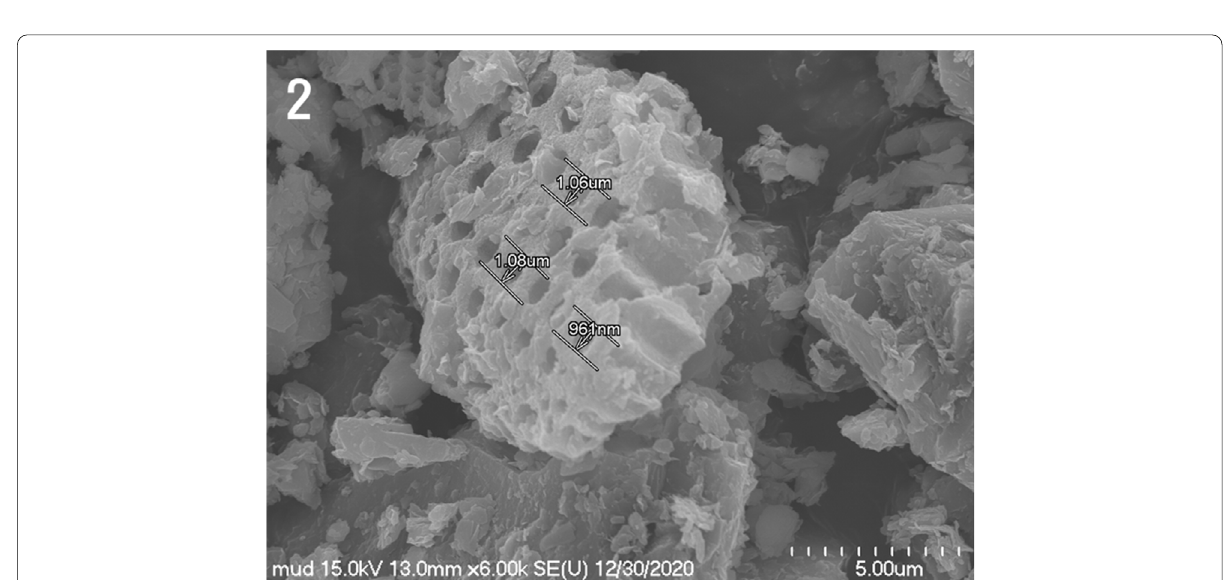
Fig. 2 Magnified scanning electron micrograph of Fig. 1 depicting the diatom